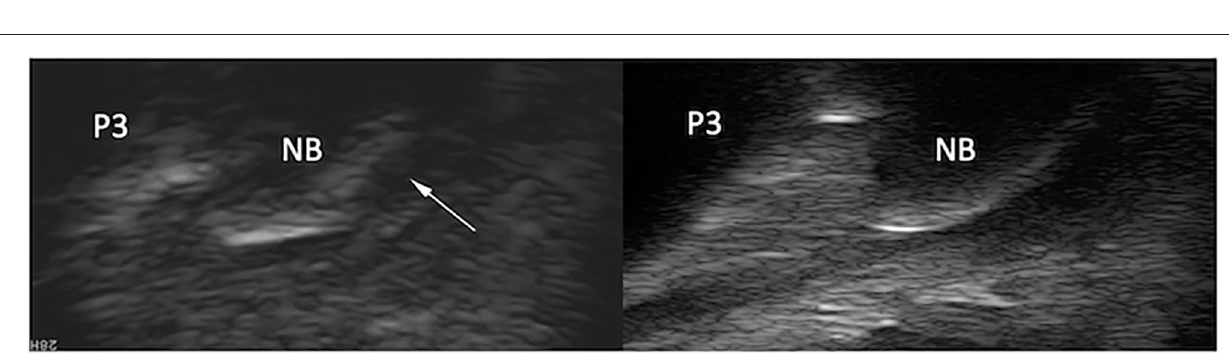
marked disruption of the dorsal tendinous border at